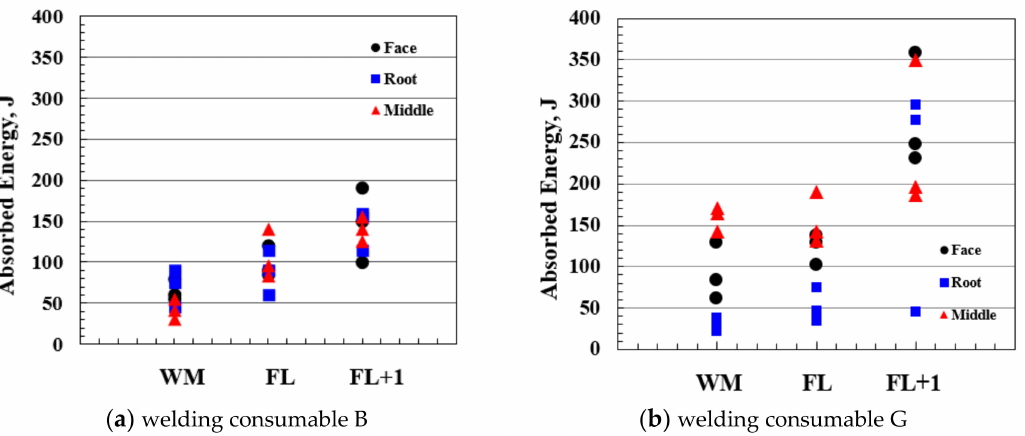
Figure 8. Charpy impact test results of welding consumables B and G. ( a ) welding consumable B; ( b ) welding consumable